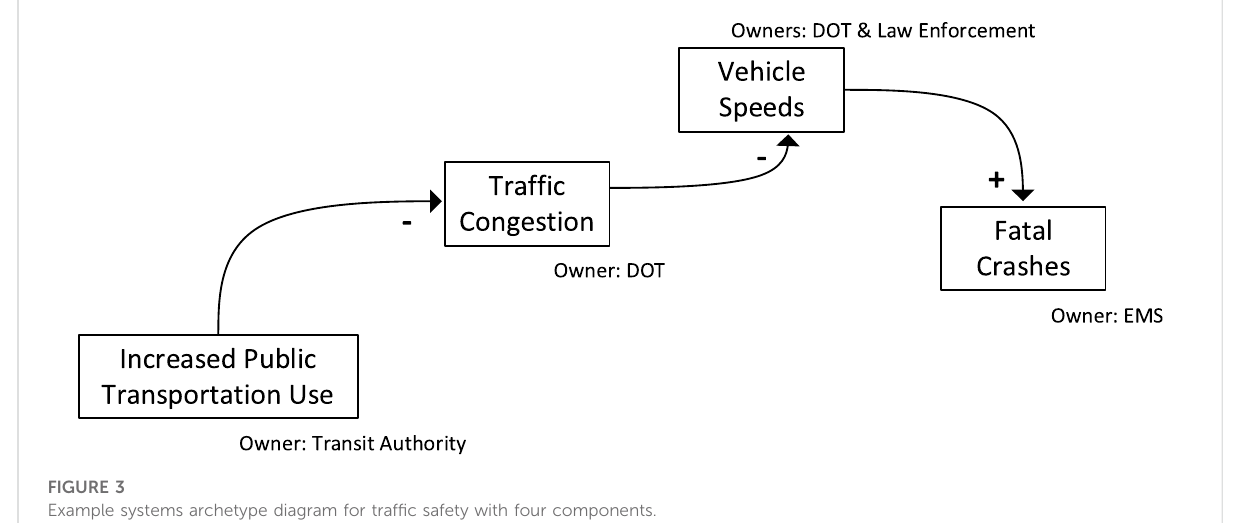
FIGURE 3 Example systems archetype diagram for traf fi c safety with four